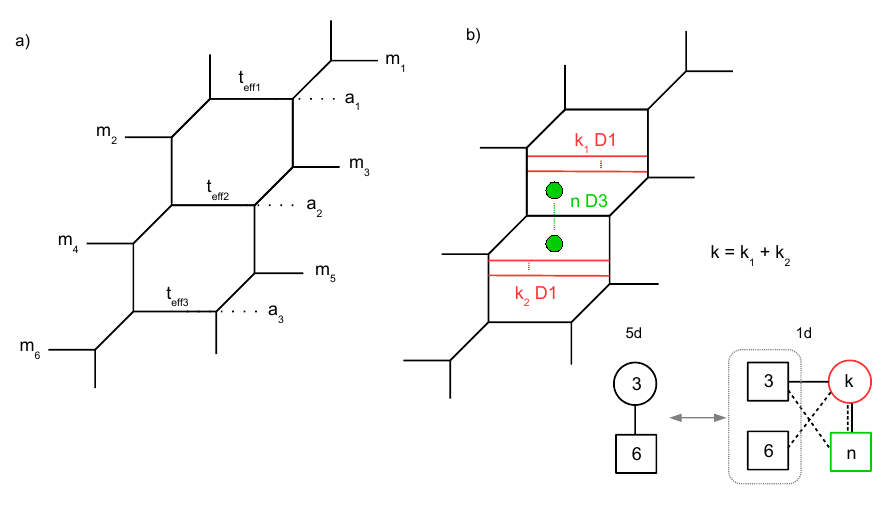
Figure 13 . a) Brane realization of the SU(3) theory with N f = 6. b) Brane setup ADHM quiver SQM for the k -instanton sector in the presence of an n D3 branes SQM